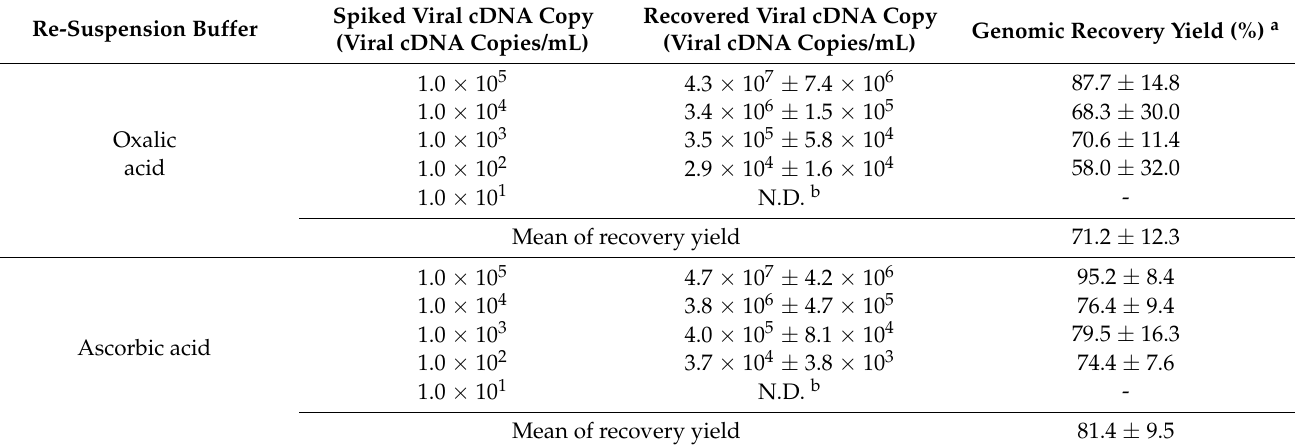
Table 2. VHSV genomic recovery yield from artificial virus-spiked seawater by qRT-PCR.